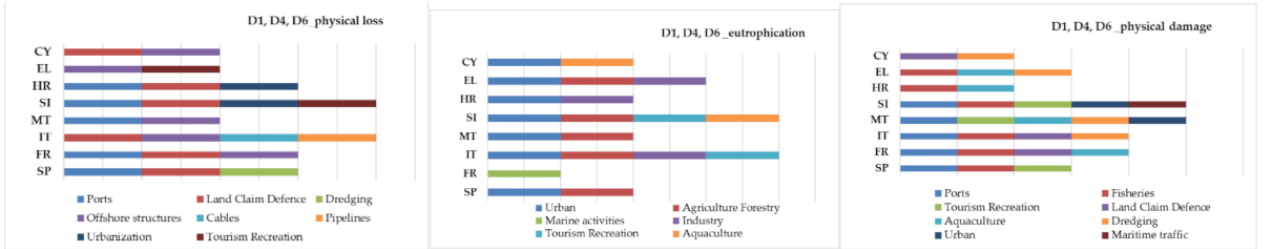
Figure 3. Main pressures impacting habitats and relevant activities reported under biodiversity descriptors by Mediter- ranean MSs in